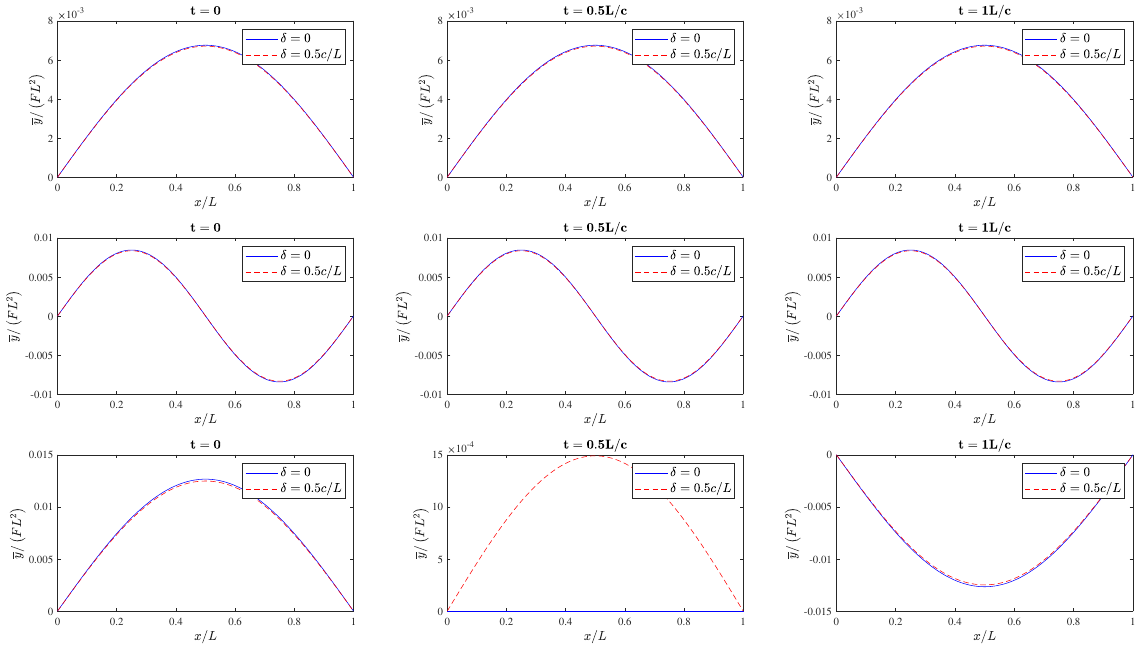
Figure 2. Forced non-resonant oscillations at three distinct times. The blue solid lines correspond to no damping, δ = 0, whereas the red dashed lines correspond to oscillations with damping, δ = 0.5 c / L . Each row corresponds to a distinct set of values of the mode of oscillation n (which influences the value of spatial wavenumber k ) and ω : the upper row is for { n , ω } = { 1,4 π c / L } , the middle row is for { n , ω } = { 2,4 π c / L } , and the bottom row is for { n , ω } = { 1,3 π c / L } . In all the cases, the wavenumber is related to n by k n = n π / L . The plots are obtained for β = 0. The values of the mode of oscillation and forced frequency influence the amplitude and phase of the oscillation. The presence of damping attenuates the amplitude of